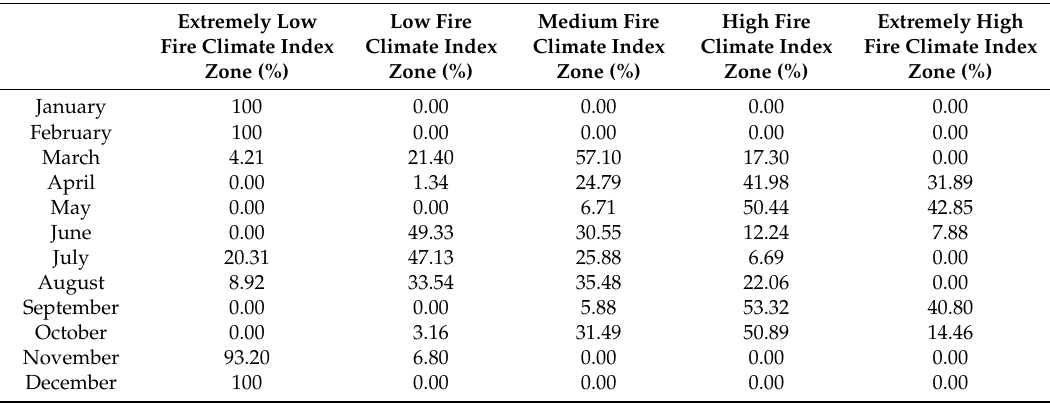
Table 4. The percent of area of grassland fire climate distribution